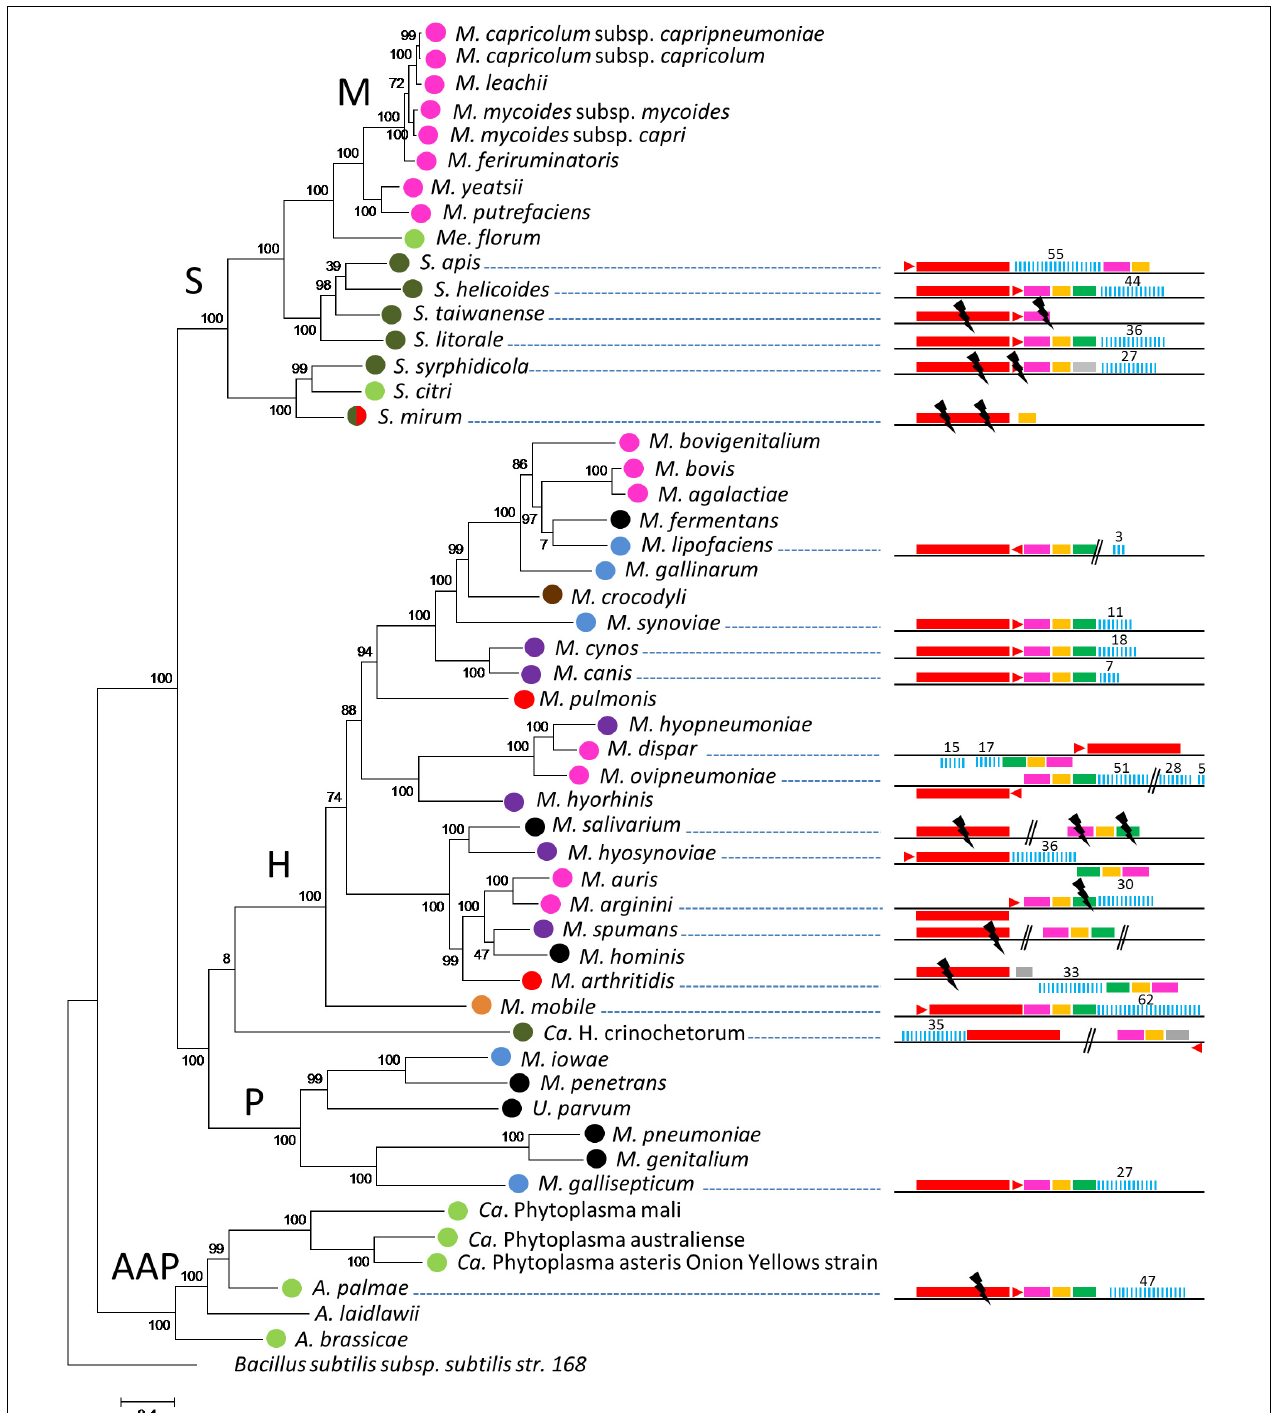
FIGURE 1 | Distribution of CRISPR systems in mollicutes. Organization of the CRISPR systems predicted in mollicutes genomes are represented on the right part. Red rectangle, cas9 ; red triangle, tracrRNA; pink rectangle, cas1 ; orange rectangle, cas2 ; green rectangle, csn2 ; gray rectangle, CDS not related to CRISPR; blue bars, CRISPR array. Above numbers indicate the number of spacers. Double bars, genome interruption; black flash, disrupted gene. The phylogenetic tree was generated using the maximum likelihood method from the concatenated multiple sequence alignments of selected 62 orthologous protein involved in translation. Main phylogenetic groups are indicated; S, spiroplasma; H, hominis; P, pneumoniae; AAP, acholeplasma/phytoplasma; M, mycoides cluster. B. subtilis was used as an outgroup. Statistical values from an Approximate Likelihood-Ratio Test are indicated on branches. Hosts are indicated by colored circles; arthropod, dark green, ruminant, pink, rodent, red, bird, blue, others mammals (cats-dogs-pigs), purple, human, black, plant/arthropod, light green, reptile, brown and fish, orange.